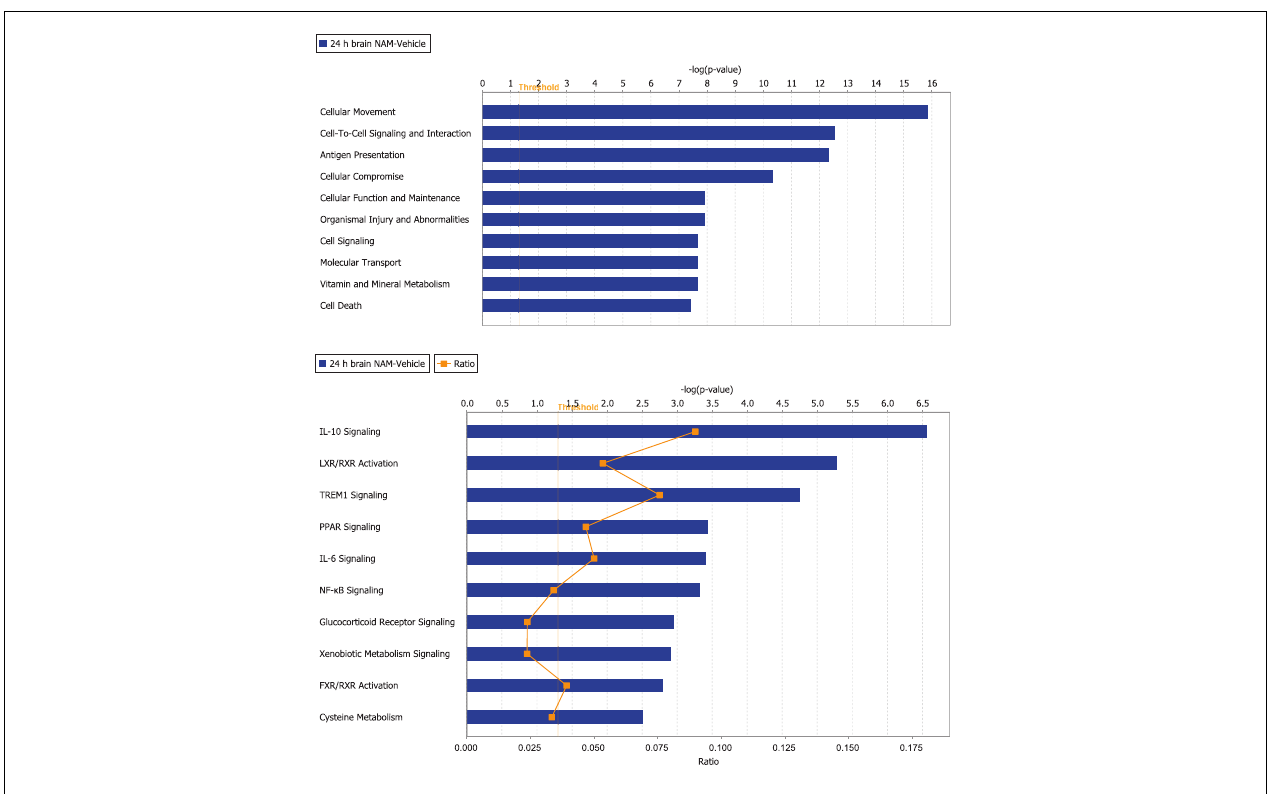
significant if it extends to the right of the threshold line − log( p < 0.05).The ratio number, is defined as the number of significant molecules in the given pathways divided by the total number of molecules that are included in the